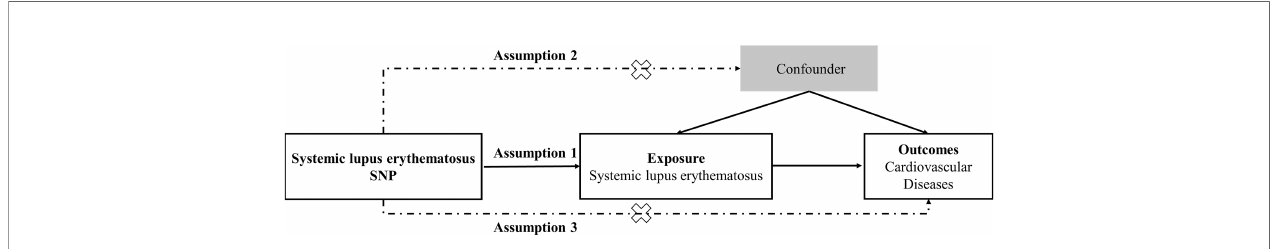
FIGURE 1 | Study design fl owchart of the Mendelian randomization study. The Mendelian randomization method is based on three hypotheses: 1. the instrumental variables is closely related to exposure; 2. instrumental variables is independent of any confounding factor; 3. instrumental variables affects the results only through exposure but not through